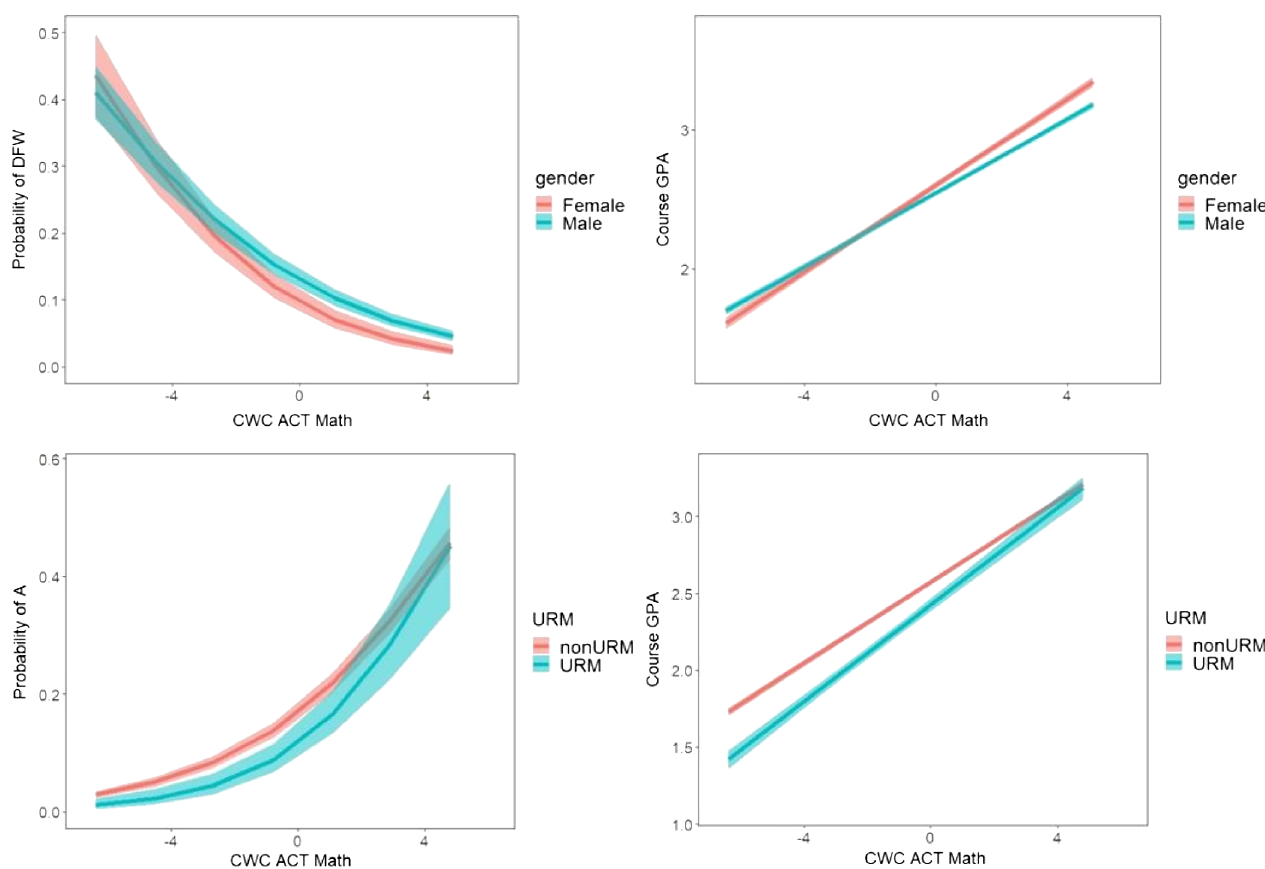
FIG. 2. Calculus-based course plots of significant interactions; probability of receiving a DFW vs group-centered ACT math score by gender, course GPA vs group-centered ACT math score by gender, probability of receiving an A vs group-centered ACT math score by URM status, and course GPA vs group-centered ACT Math score by URM